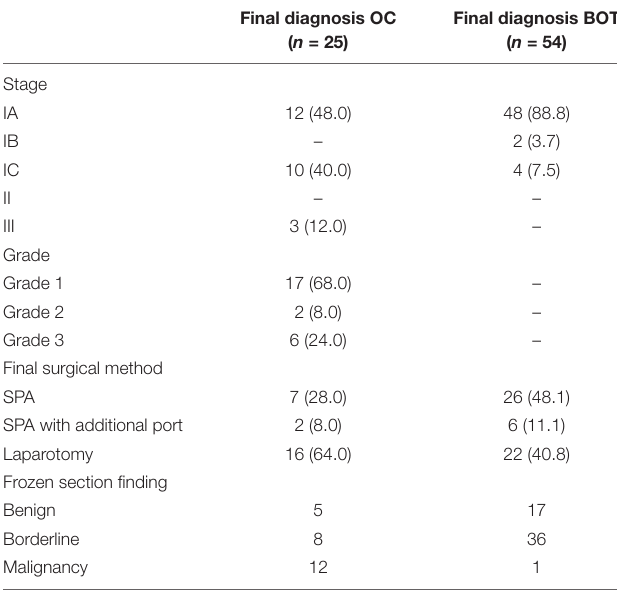
for early stage ovarian cancer in 1,545 patients, rupture during surgery was found to be associated with shorter disease-free survival (HR 1.64, p = 0.022) (14). In contrast, a meta-analysis showed that intraperitoneal rupture of early stage ovarian cancer did not increase the risk of disease recurrence in patients who received complete staging along with adjuvant platinum- based chemotherapy (16). For BOT patients, the association of intraperitoneal spillage of tumor contents with the